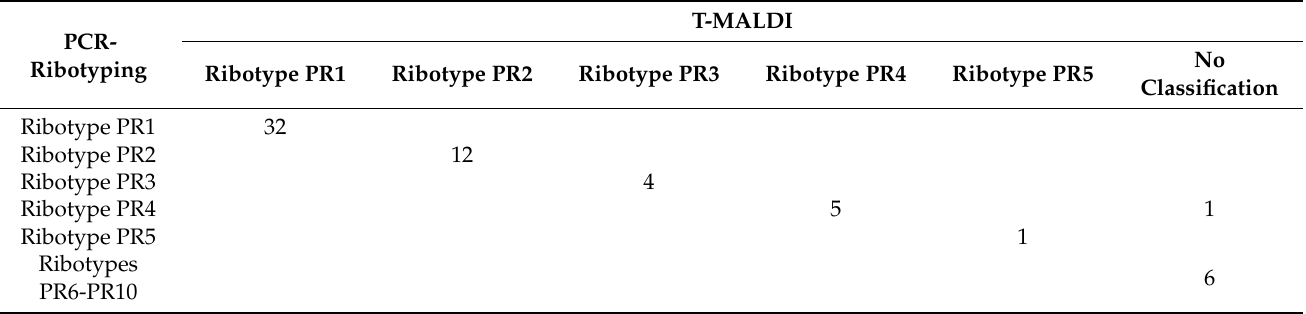
Table 2. Matrix Assisted Desorption/Ionization-Time of Flight Mass Spectrometry (MALDI-TOF MS) typing (T-MALDI) results performed on 61 C. difficile strains based on the second classifying algorithm model.